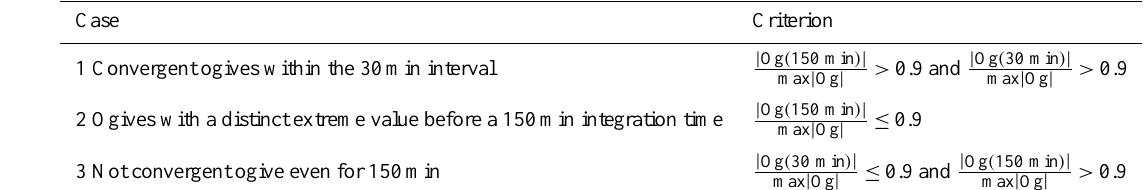
Table 3. Definition of three different cases for the behaviour of Ogive functions.